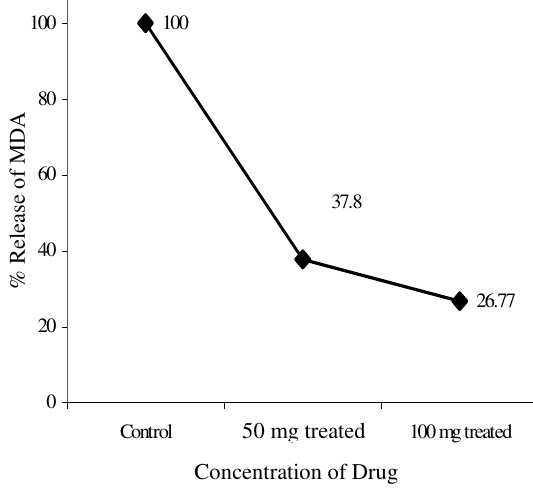
Figure 1. In vitro antioxidant effect of the